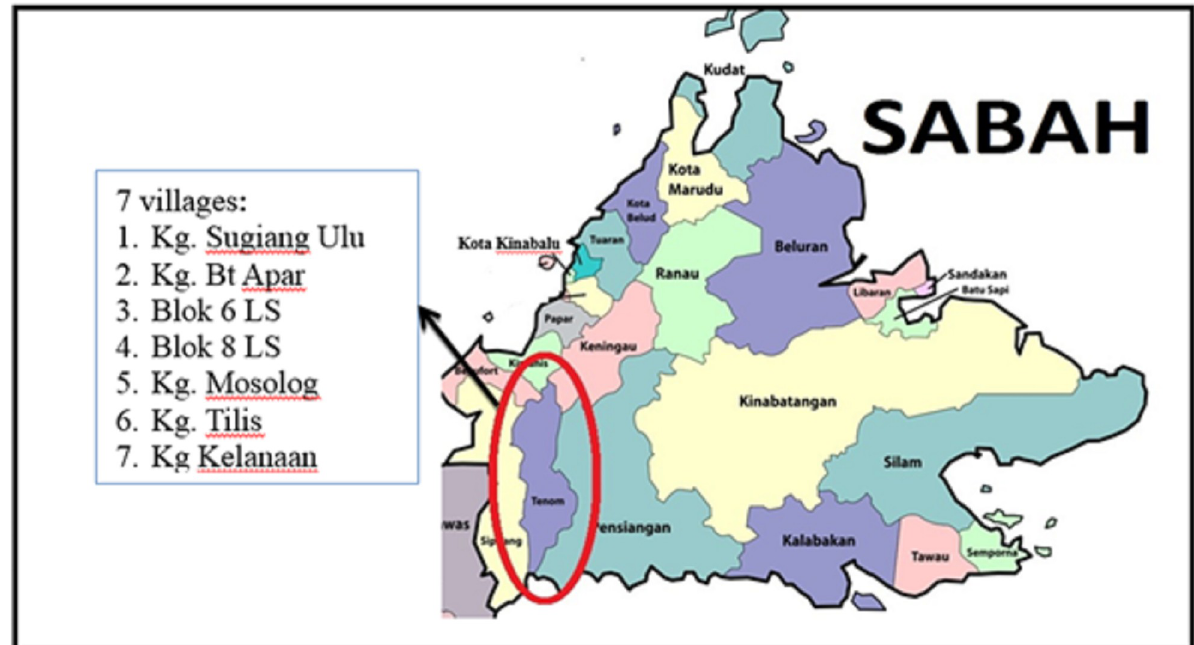
Fig 1. The location of the seven villages in Tenom, Sabah where the study was conducted.